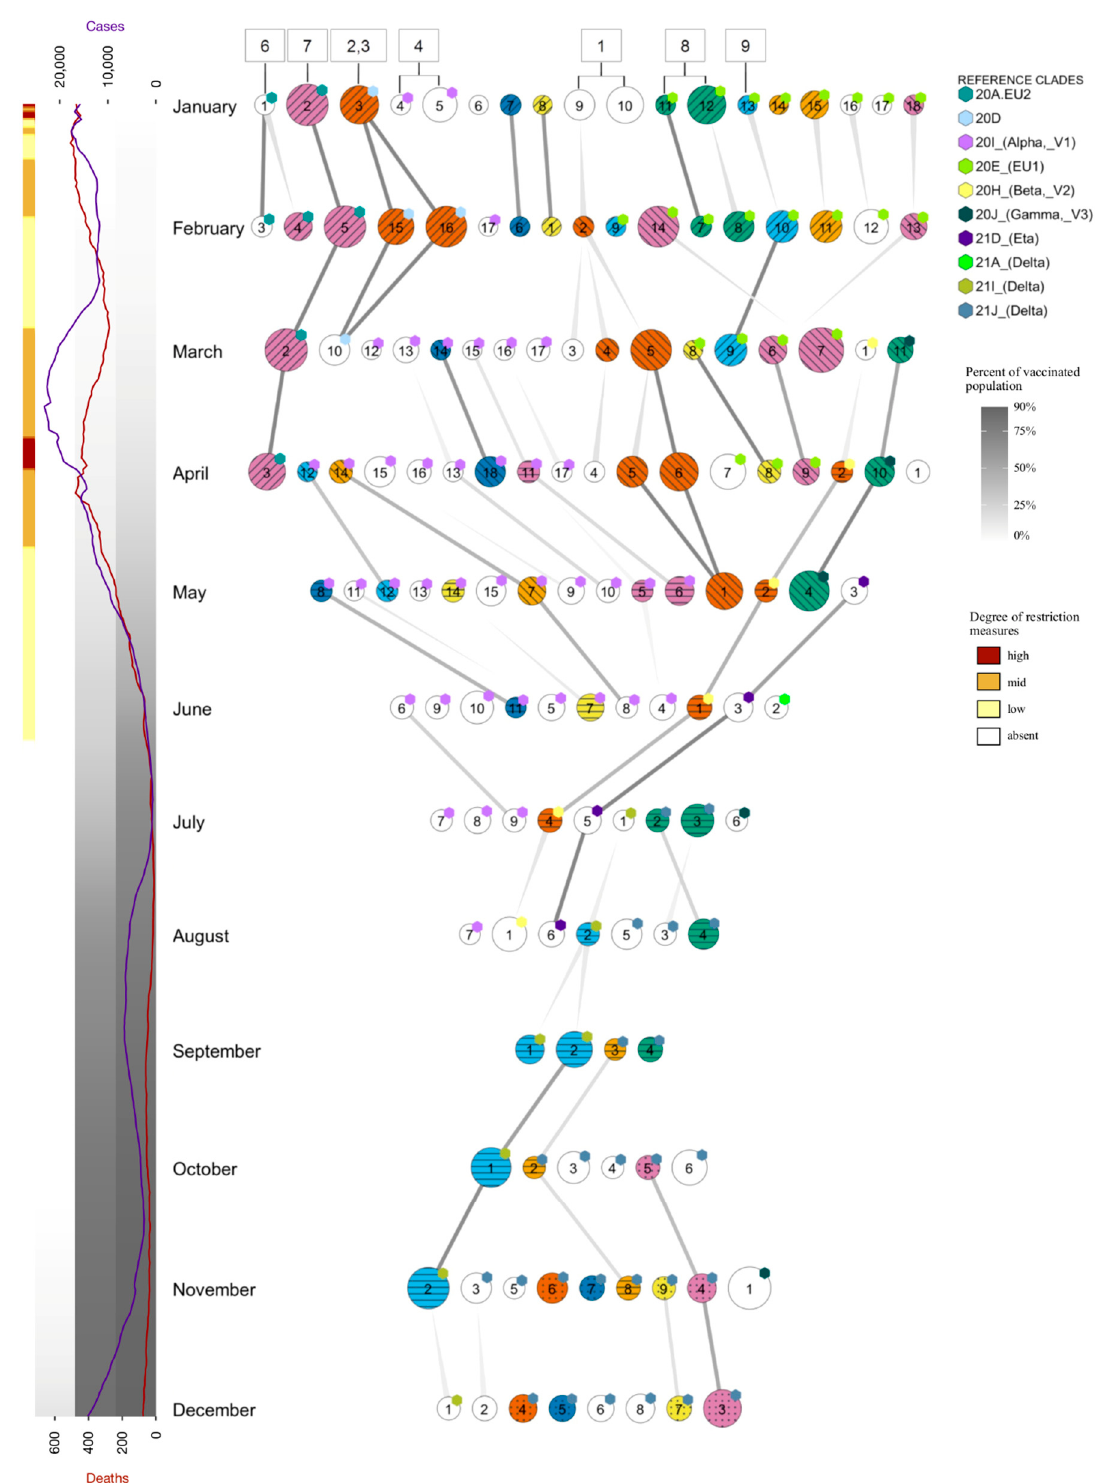
Figure 4. Tracing of growing subsets over the year 2021. Each horizontal line corresponds to a dataset consisting of sequences available at the beginning of the month indicated on the left side. The circles correspond to the subsets identified with the procedure used for Figure 2 and Table 1, with the